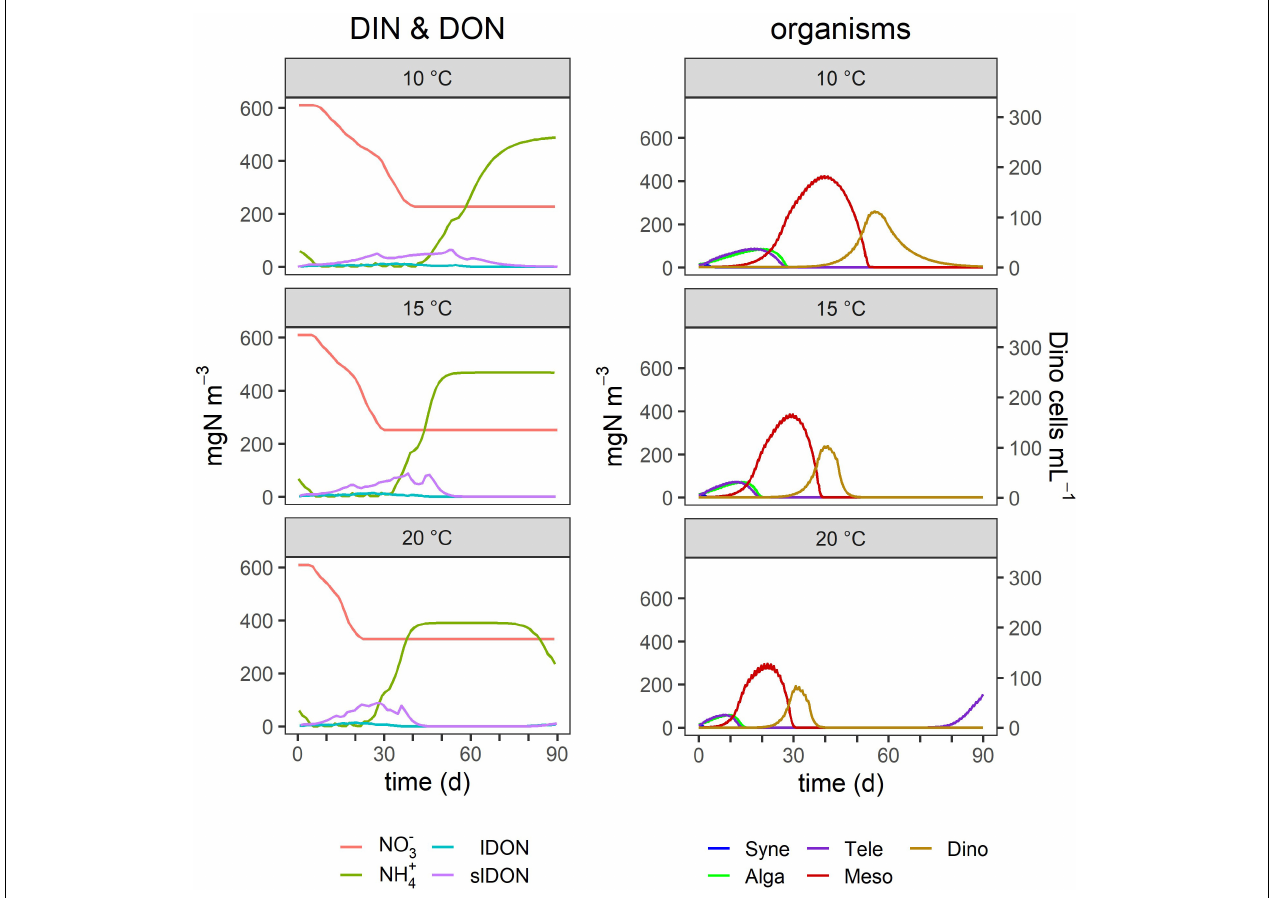
FIGURE 7 | Effect of temperature on TMD dynamics. The outputs for 15 ◦ C replicate the conditions used for Figure 4 . Other details as given in Table 4 and in the legend of Figure 4